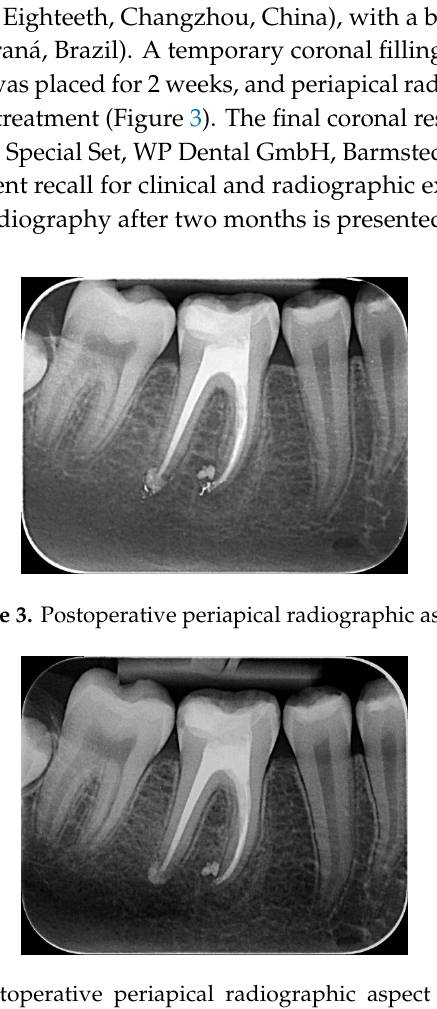
Figure 4. Two-month postoperative periapical radiographic aspect reveals the healing of the periapical